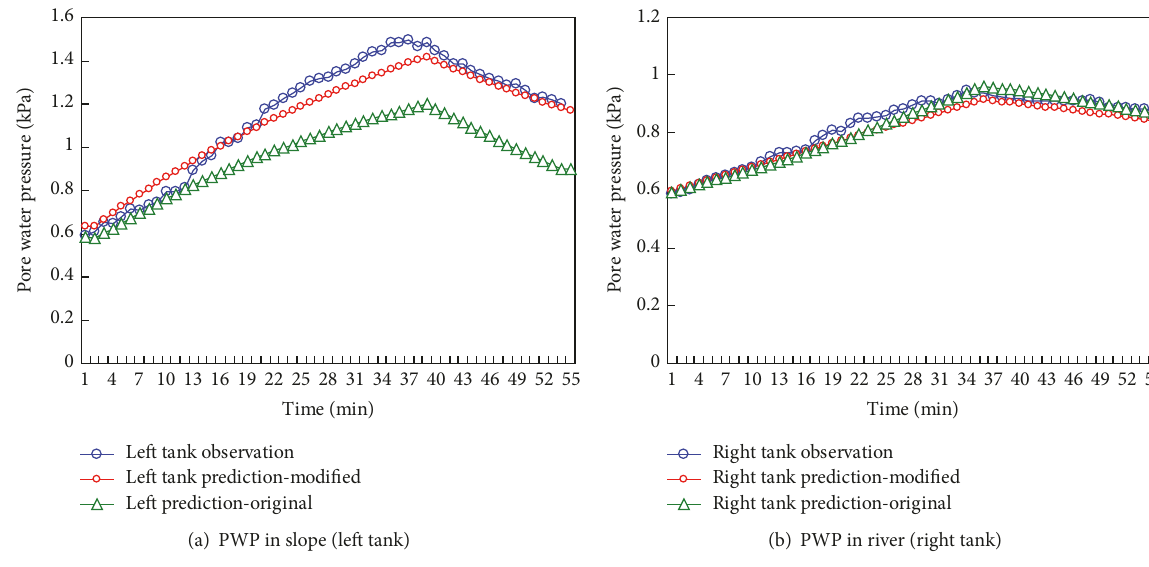
Figure 5: Predictions of original and modified tank models (fine material): (a) PWP in slope and (b) PWP in